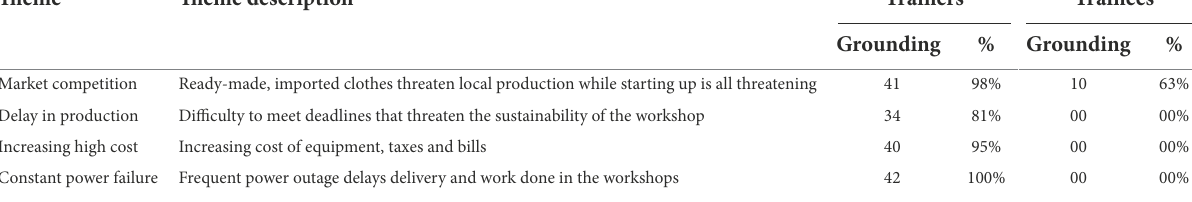
TABLE 5 Perceived threats of informal training and sustainable livelihoods of unemployed